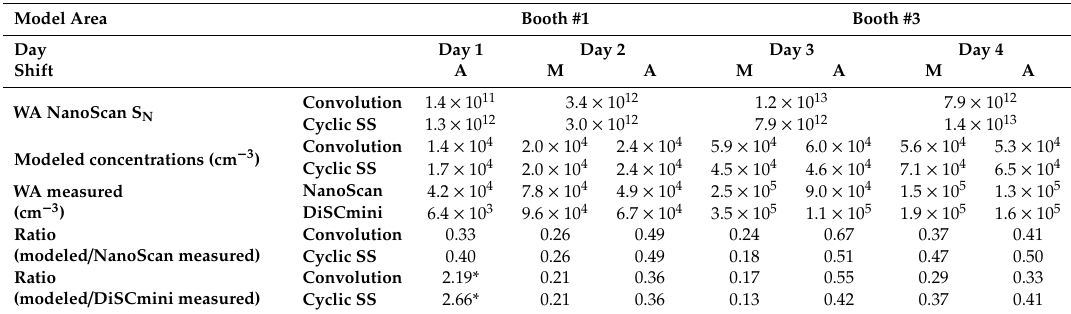
Table 2. One-Box modeled concentrations using the convolution theorem and the cyclic steady state (Cyclic SS) approach to calculate emission rate (S N ) from NanoScan data. Emission rates were calculated for each day considering all activity periods, and modelings were applied for morning (M) and afternoon (A) periods (shift) separately. Booth